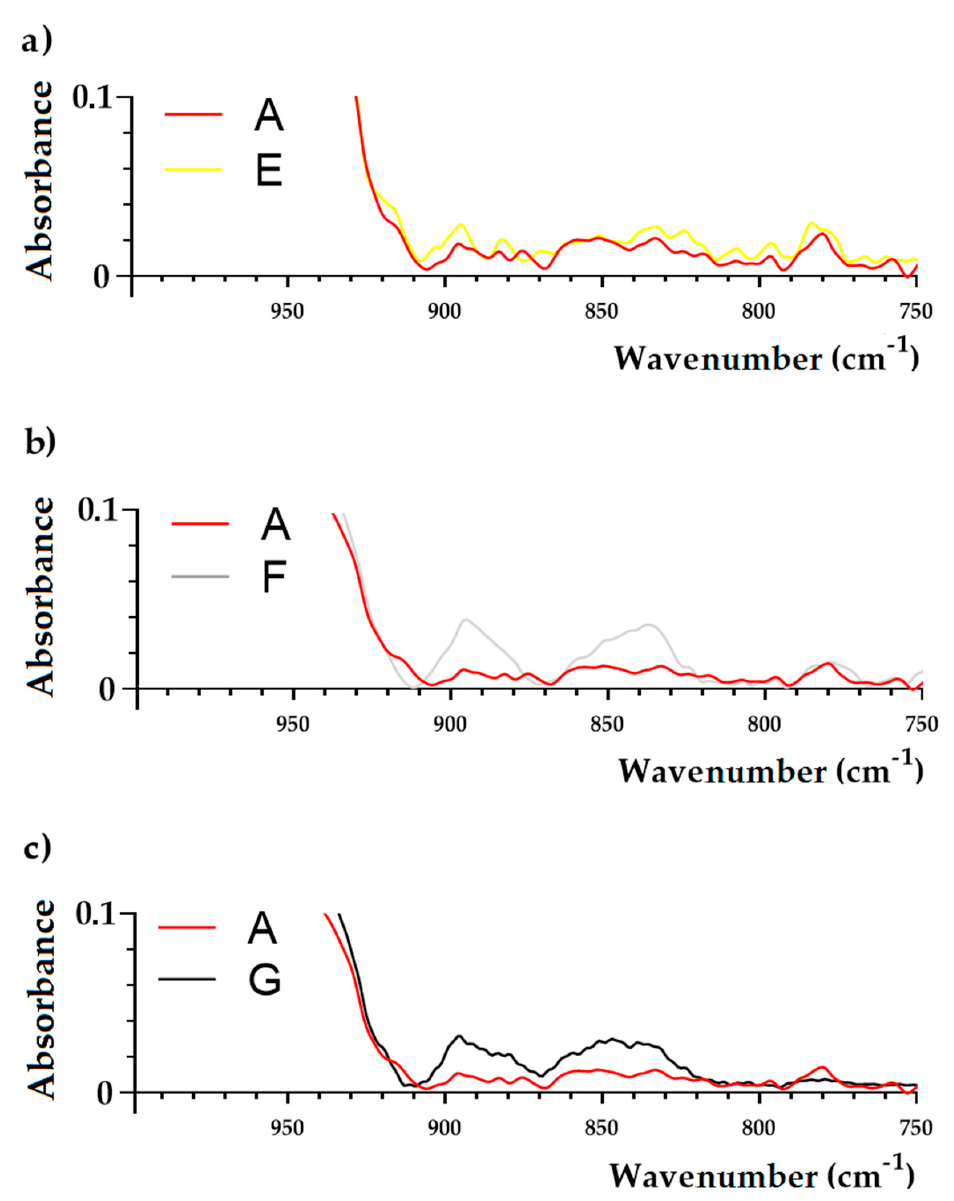
Figure 4. FTIR spectra (in the range: 950–700 cm − 1 ) of Staphylococcus aureus ATCC 43300 (MRSA) strain grown in Mueller-Hinton broth containing: no chemicals (control—medium A), lavender essential oil (LEO) at subinhibitory concentration (MIC 50 ) (medium E), octenidine dihydrochloride (OCT) at subinhibitory concentration (MIC 50 ) (medium F), LEO / OCT at subinhibitory concentrations (MICc 50 ) (medium G).